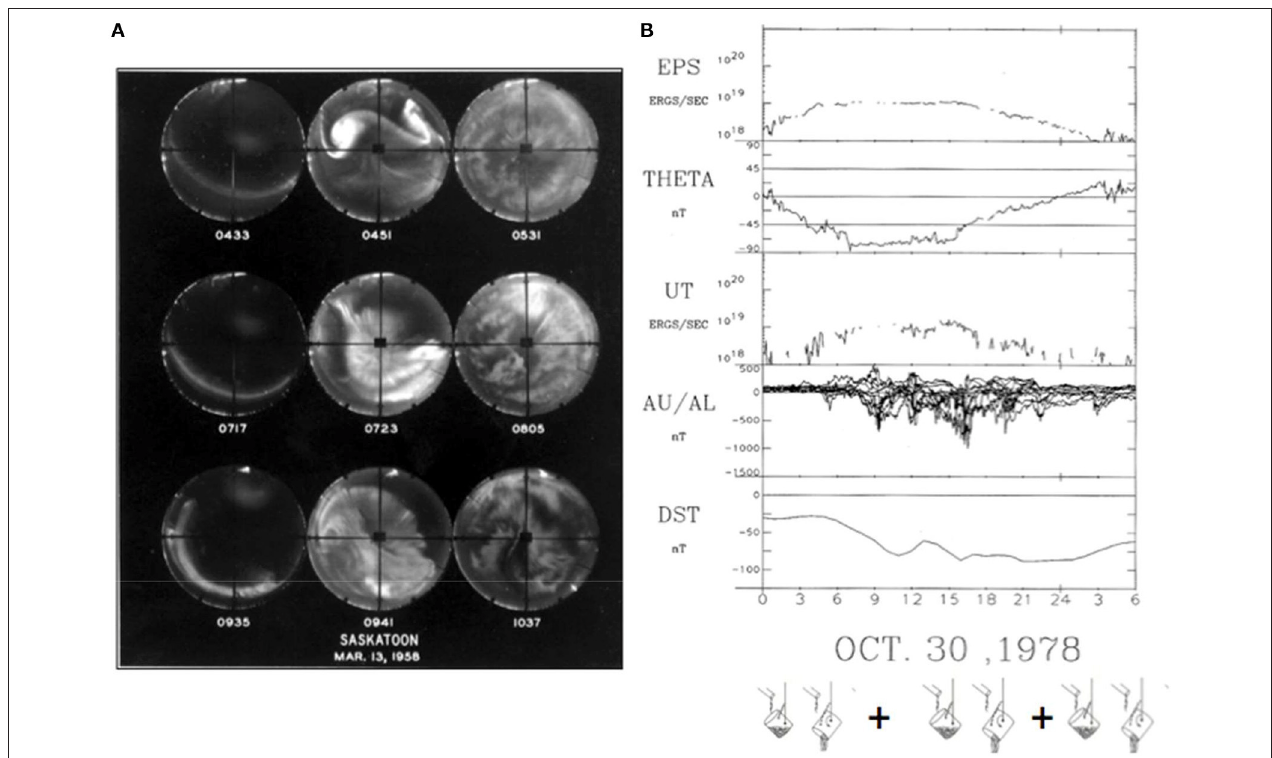
FIGURE 14 | (A) an example of three successive substorms, repeating the poleward expansions during a single night. (B) when the dynamo power is continuously high (10 19 erg/s), substorms occur successively (not continuously); the tippy pitchers are shown to indicate such a situation. This example occurred during a intense geomagnetic storm of October 30,